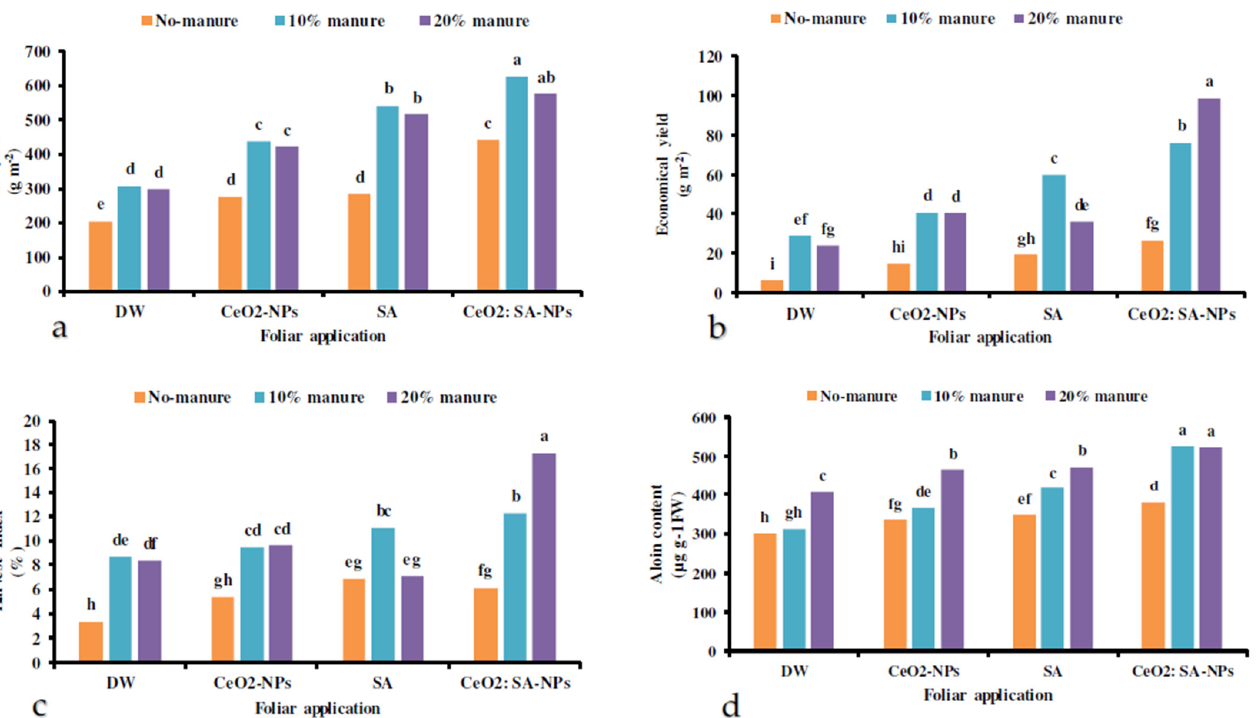
the plant compared to the control. The 20% manure × foliar CeO 2 : SA-NPs treatment im- proved the economic yield by 29% compared to the 10% manure × CeO 2 : SA-NPs treat- ment. Contrarily, the lowest economic yield was recorded in control plants (Figure 3b).